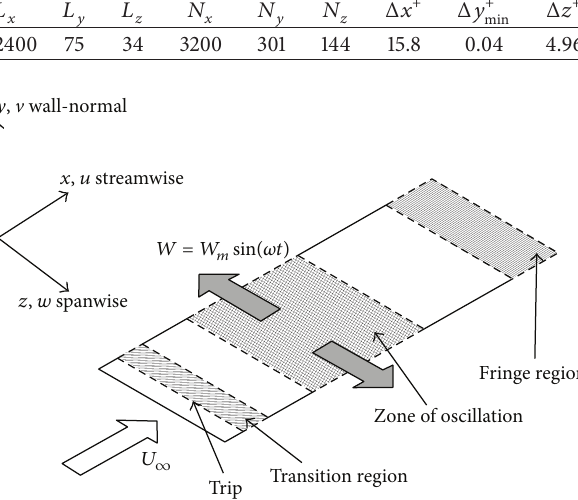
Figure 2: Illustration for the problem